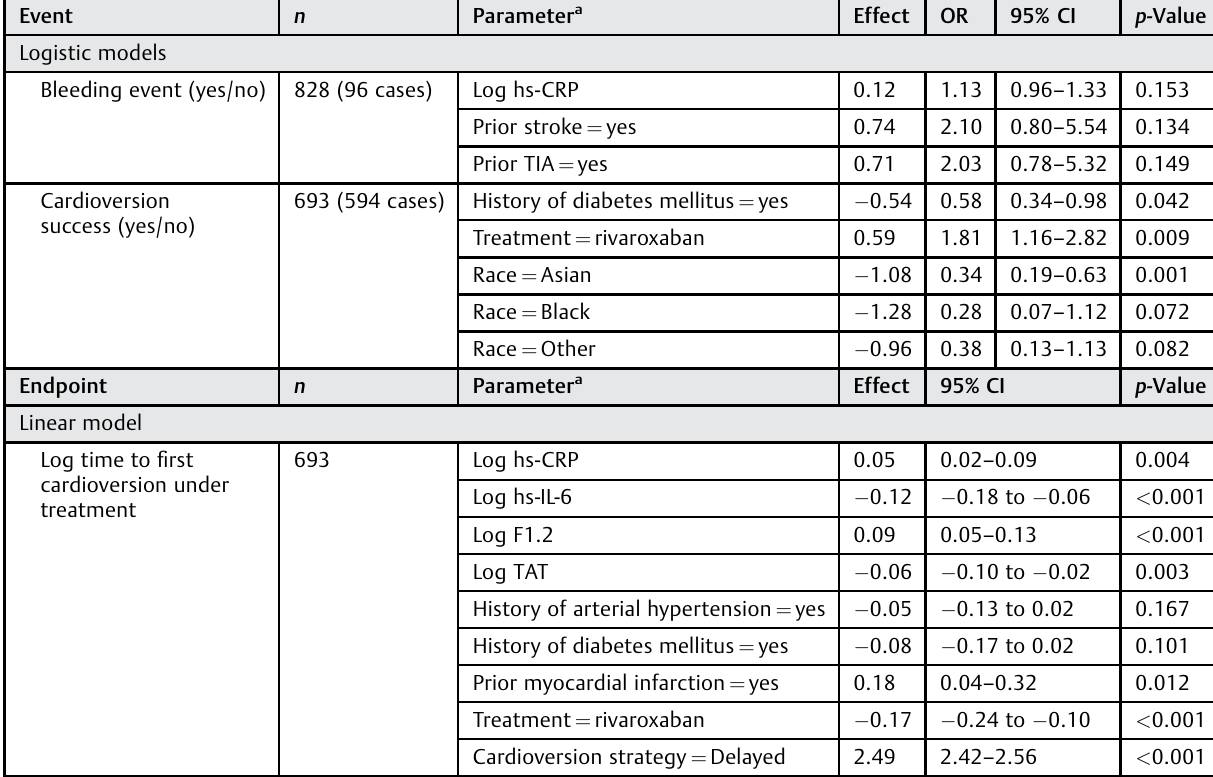
Table 2 Results of multivariate models for bleeding events, cardioversion success and time to cardioversion by biomarker baseline levels, and demographic and clinical covariates